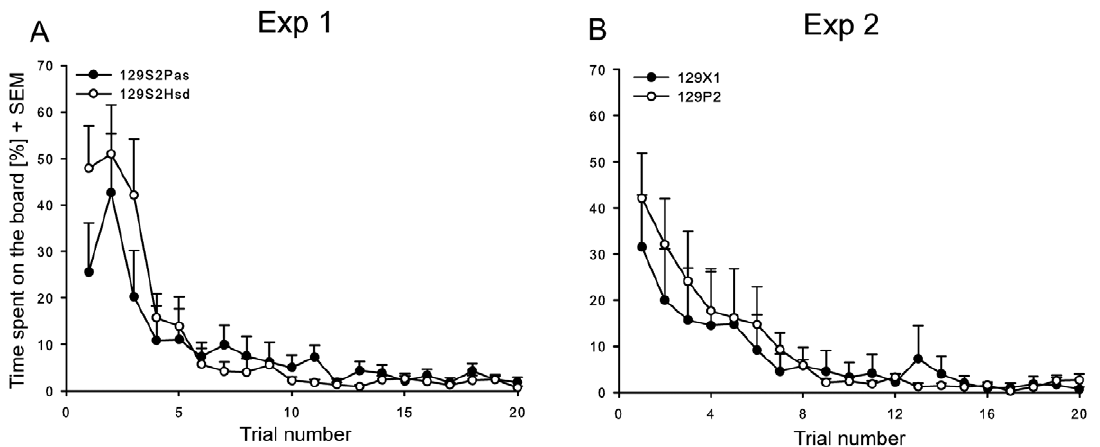
Figure 2. Total percentage of time spent on the board (% + SEM). (2A) Experiment 1: 129S2Pas and 129S2Hsd mice, (2B) experiment 2:129P2 and 129X1 mice.